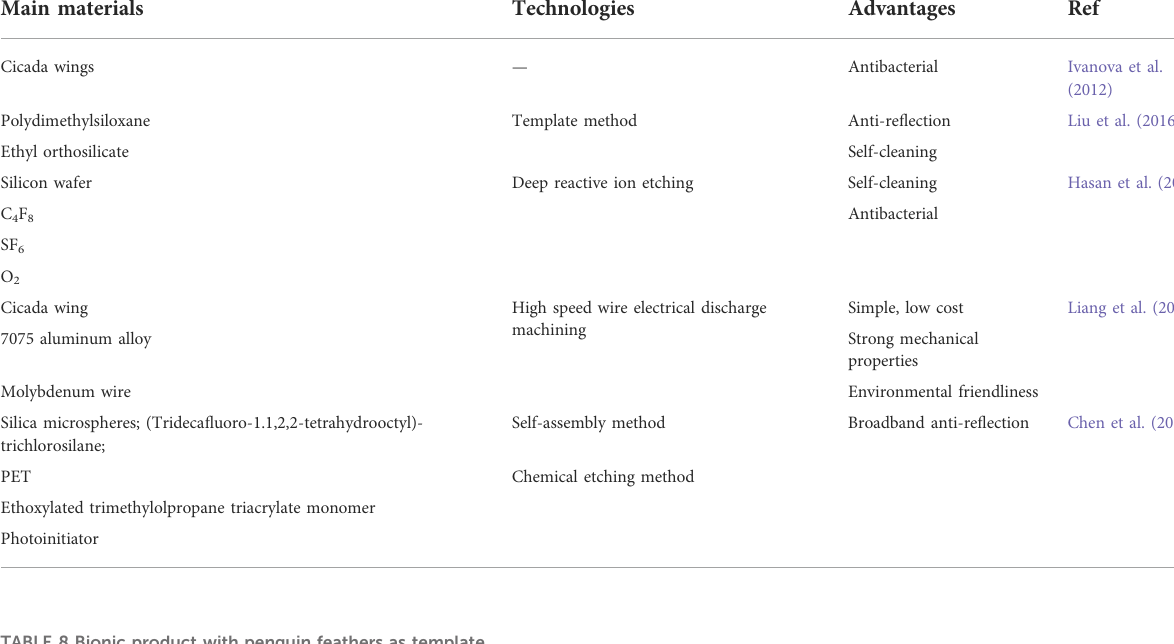
TABLE 8 Bionic product with penguin feathers as